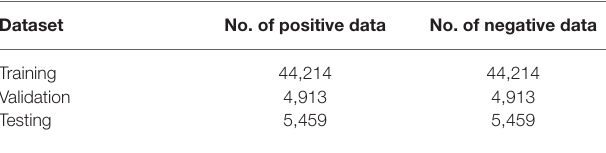
TABLE 1 | Data on protein ubiquitination